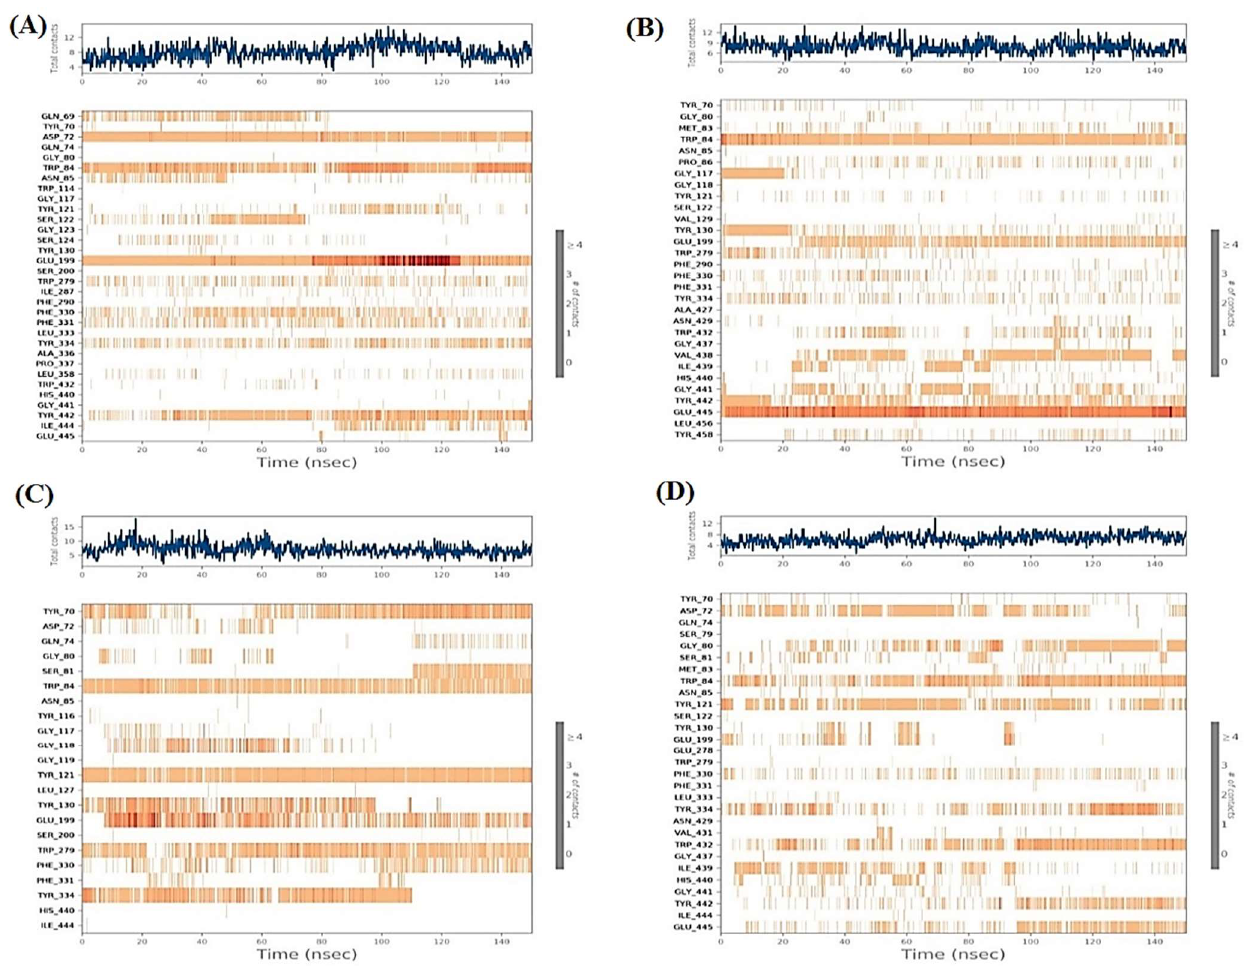
Figure 8. Heat map showing the total number of protein-ligand interactions with respect to the simulation time of 150 ns for: ( A ) normethyl budmunchiamine K-1OCE; ( B ) budmunchiamine L5-1OCE; ( C ) donepezil-1OCE and ( D ) MF2 700-1OCE complexes.